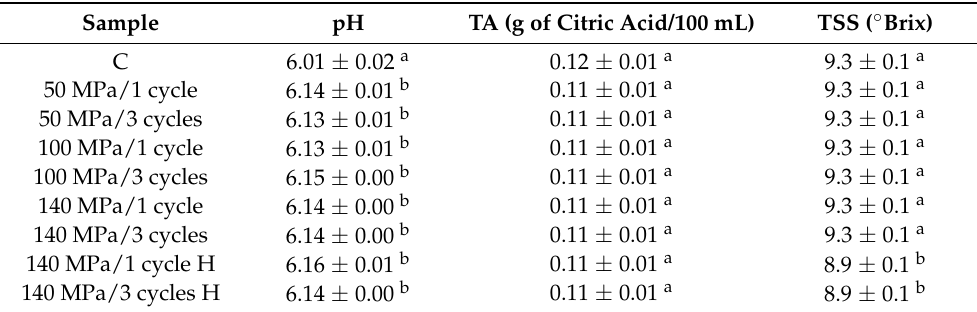
Table 2. The physicochemical characteristics: total soluble solids (TSS), pH and titratable acidity (TA) of beetroot juice samples treated with